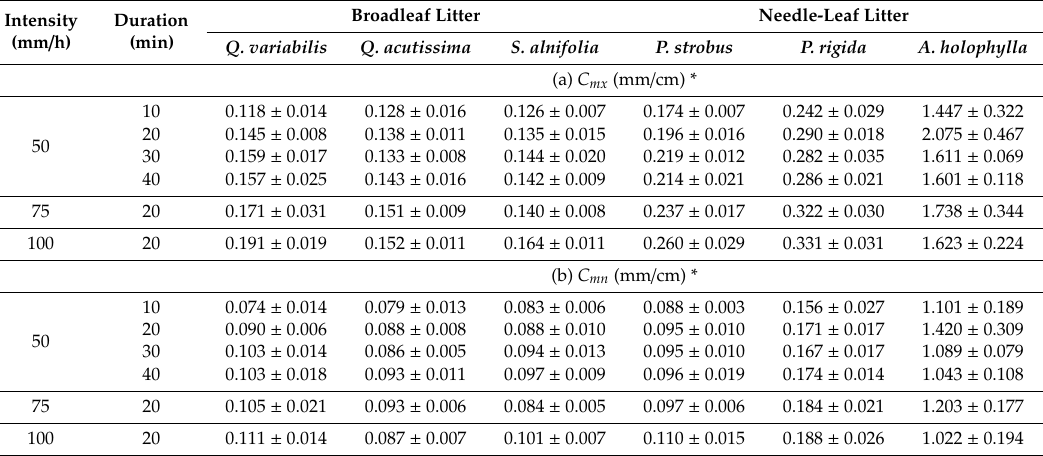
Table 3. Variations of C mx and C mn across litter type and